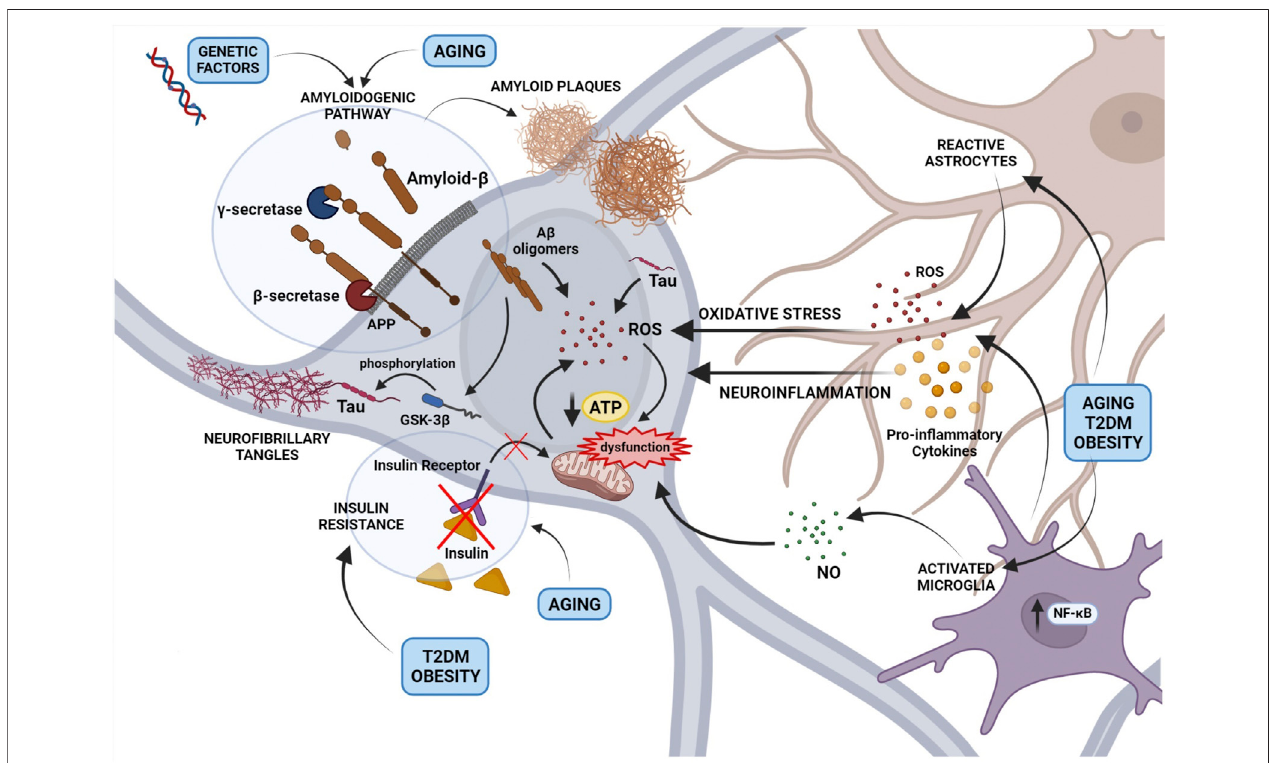
FIGURE 1 | An overview of the main mechanisms involved in Alzheimer ’ s disease pathogenesis and their interplay according to a multi-factorial hypothesis. The fi gure depicts the role of the amyloidogenic processing of the Amyloid Precursor Protein (APP) induced by genetic factors or aging, in the formation of Amyloid- β (A β ) oligomers and extracellular amyloid plaques. Small A β aggregates contribute to reactive oxygen species (ROS) production and mitochondrial dysfunction, formation of Tau aggregates and neuro fi brillary tangles (NFTs). In addition, the activation of astrocytes and microglia, resulting in the release of cytokines, ROS, and nitric oxide, contributetoneuronaloxidativestressandmitochondrialdysfunction.Mitochondrialdamagecausedbyaneuroin fl ammatorymilieau, agingormetabolicdisorderssuch as Type 2 diabetes mellitus and obesity induces the accumulation of free radicals and impairs the energetic ef fi ciency of the